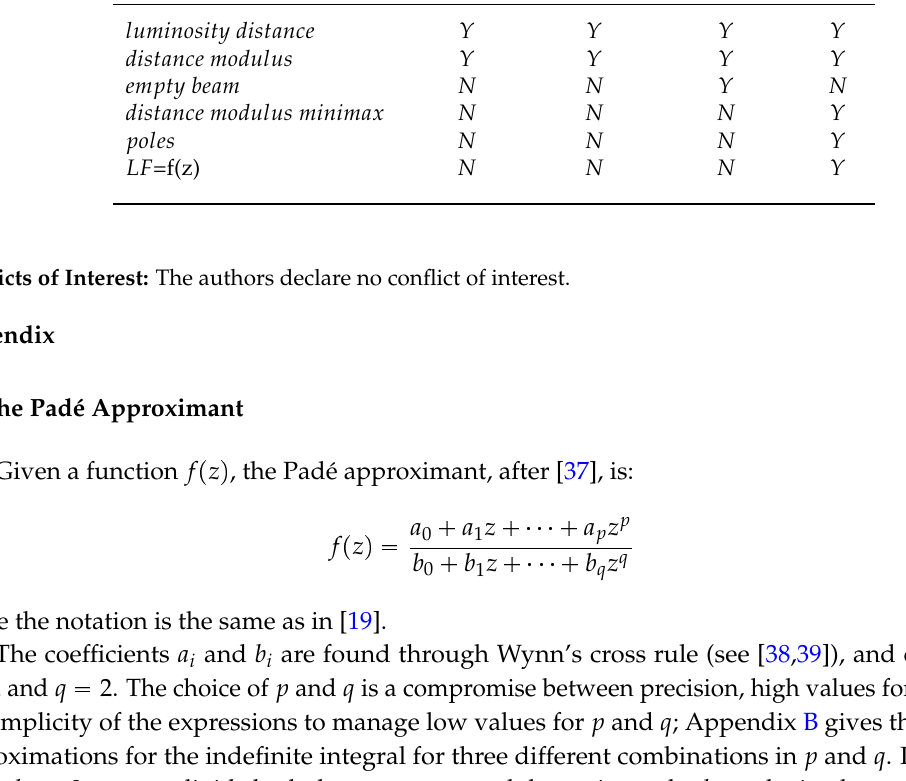
Table 7. Arguments treated in papers on Padé approximants and here. Problem Aviles 2014 Wei 2014 Adachi 2012 Here luminosity